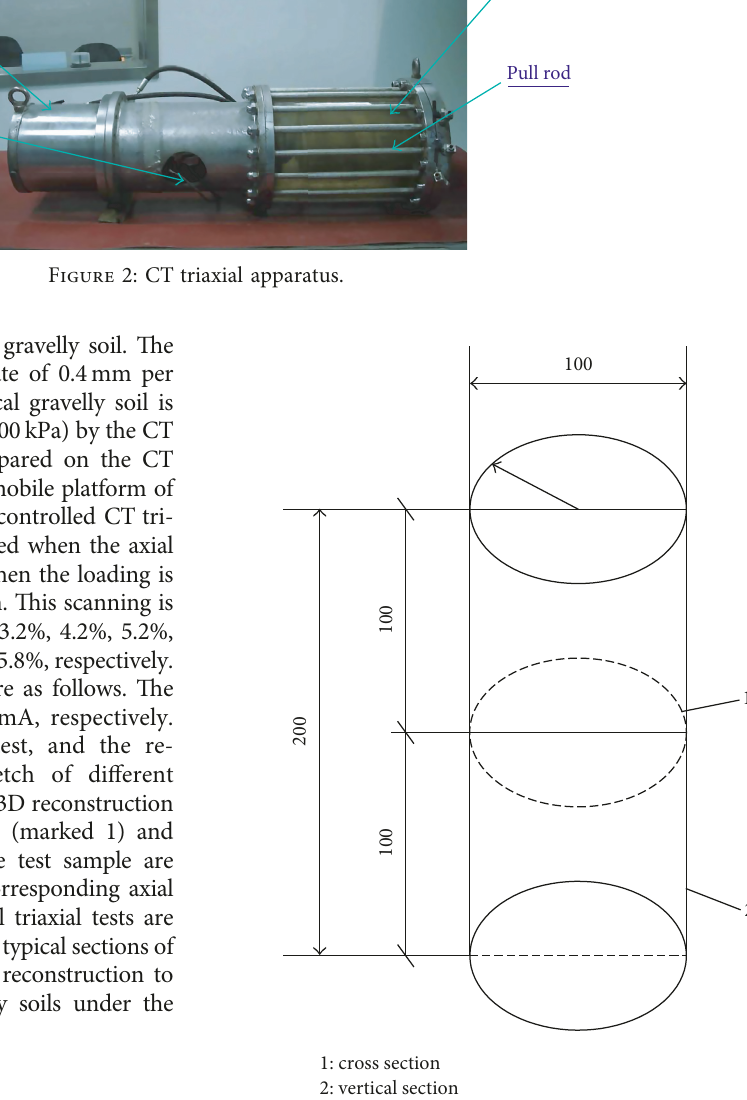
Figure 3: Sketch of the scanning position of the soil sample (unit: